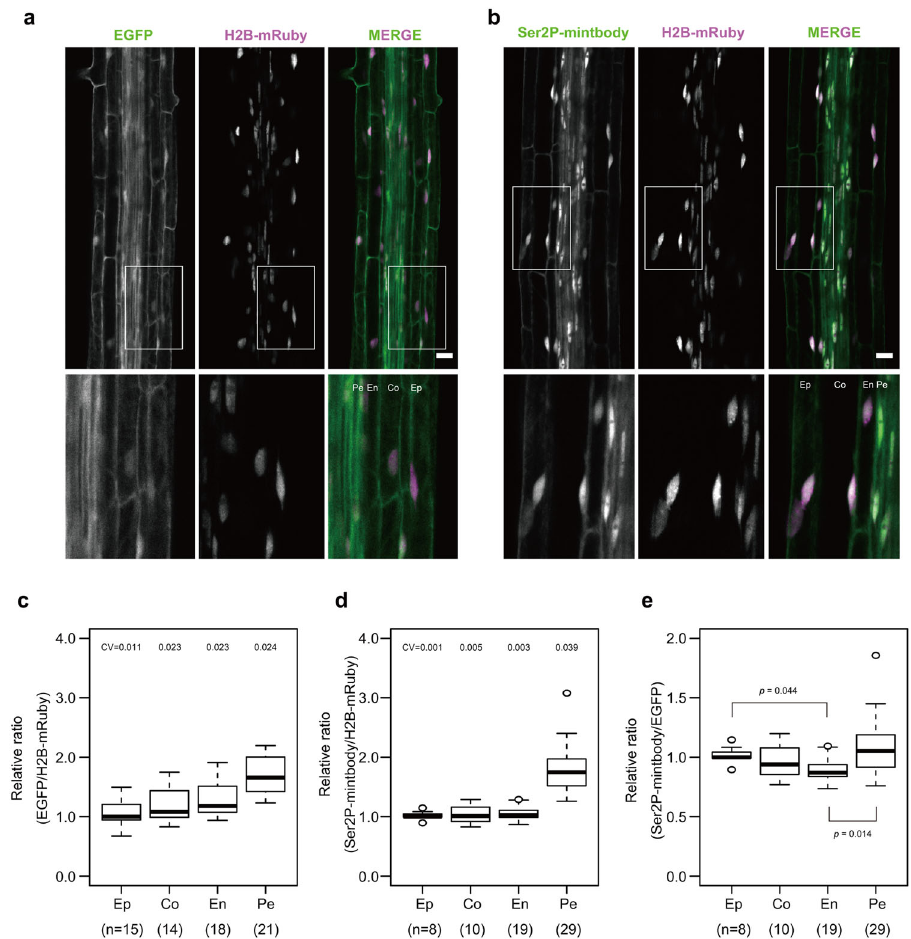
Fig. 4 Variation of general transcription activity among tissues in the root. a , b Live cell imaging of EGFP or Ser2P-mintbody and H2B-mRuby in the root elongation zone. Panels are sum slices of Z-stacks. Lower panels are enlarged from the inset of upper panels. Scale bars, 20 µ m. Ep Epidermis, Co Cortex, En Endodermis, Pe Pericycle. c , d EGFP or Ser2P-mintbody/H2B-mRuby intensity ratios in epidermis, cortex, endodermis, and pericycle cells normalized by the median ratio in the epidermis. Data from three distinct roots (three distinct normalization scales) are accumulated. n = biologically independent cells. CV coef fi cient of variation. e Ser2P levels in Fig. 4d divided by the median ratio in each tissue in Fig. 4c. p Values were calculated with the Bonferroni- adjusted unpaired Wilcoxon rank sum test. p Values less than 0.05 are shown. n = biologically independent cells. Source data underlying the plots are available as Supplementary Data